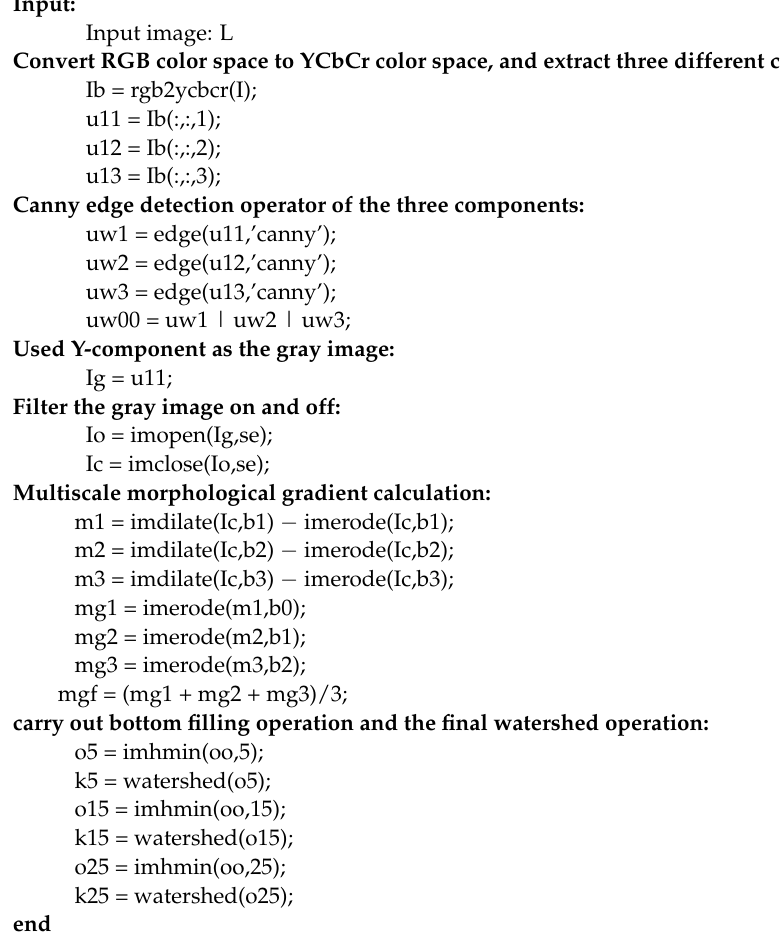
Algorithm 1 Improved